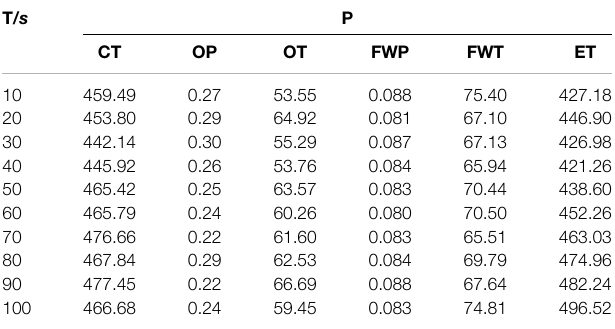
TABLE 7 | Collected data of engine equipment from normal operation to fault 3.